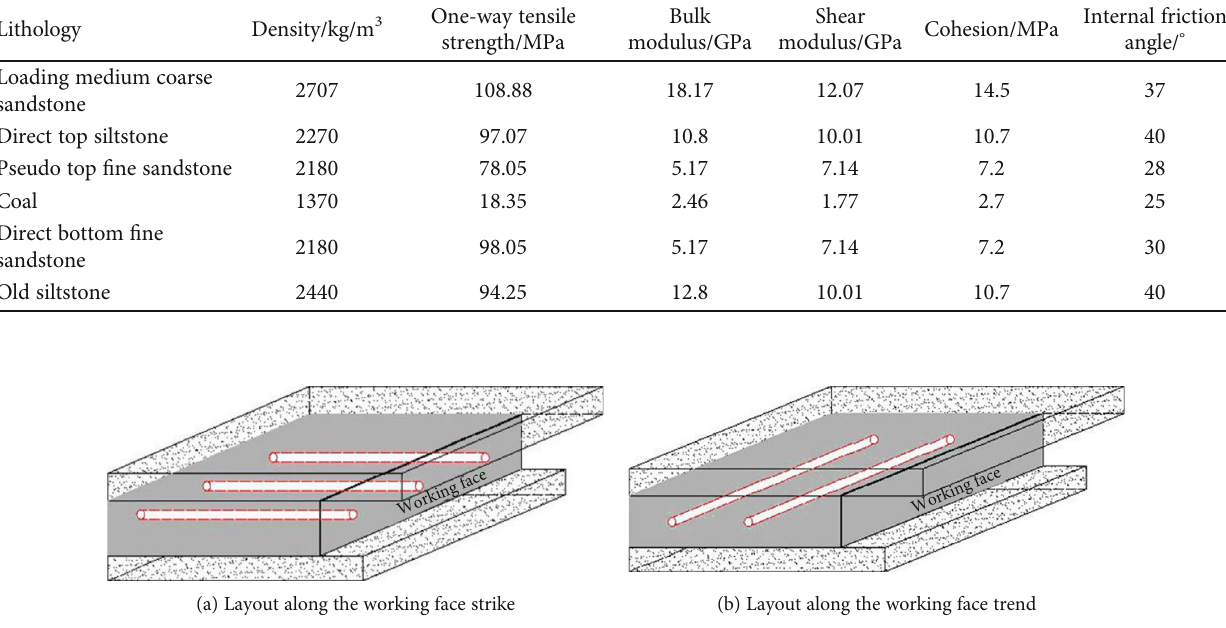
Figure 12: Simpli fi ed diagram of drilling holes in di ff erent layout directions.